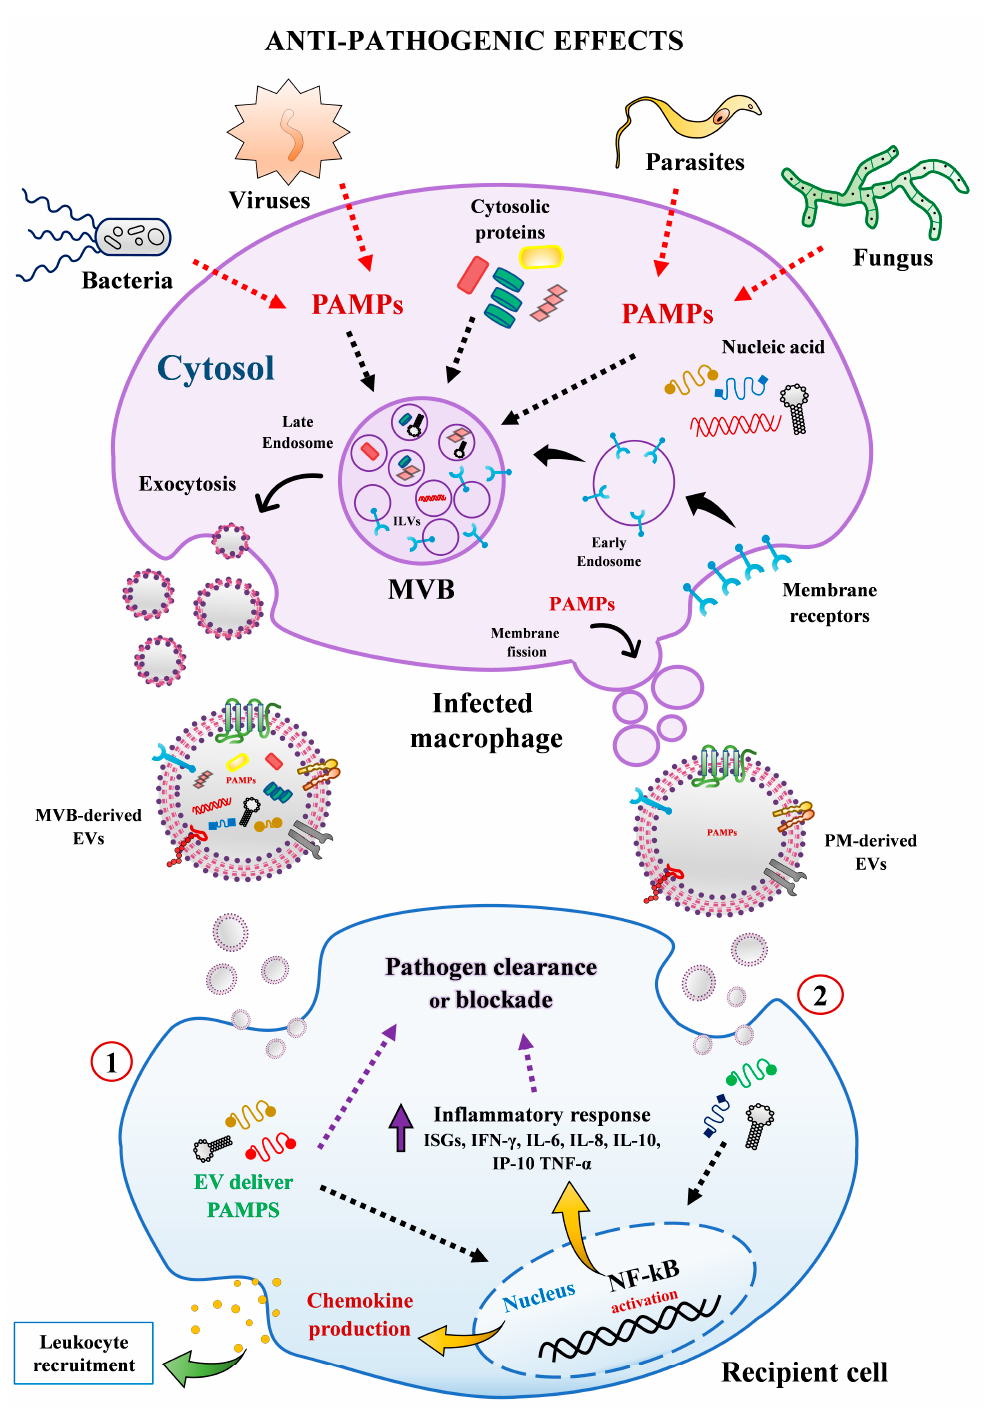
Figure 4. Anti-pathogenic effect mediated by EVs released from human macrophages. EVs secreted by infected macrophages may stimulate the clearance or blockade of pathogen growth in recipient cells by the following ways: (1) transporting PAMPs or pathogens antigens to enhance the expression of chemokines and recruitment of leukocytes to control the pathogen dissemination. (2) Transferring or stimulating proteins and molecules with anti-pathogenic effects, such as IFN- γ , IL-1 β , IL-8, IL-6, IL-10, IP-10, TNF- α to diminish cell permissiveness to pathogen invasion. Abbreviations: MVBs, multivesicular bodies; PAMPs, pathogen-associated molecular patterns; PM, plasma